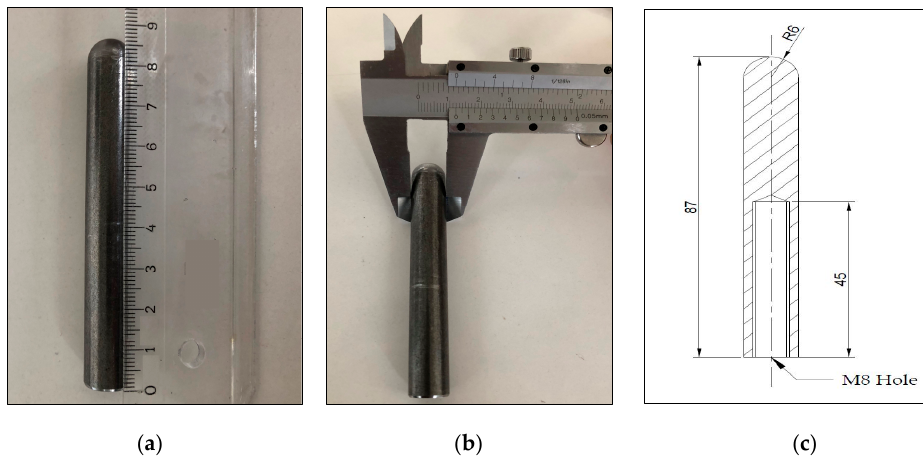
Figure 2. ( a ) Pin length; ( b ) Pin Diameter; ( c ) Technical drawing of pin.